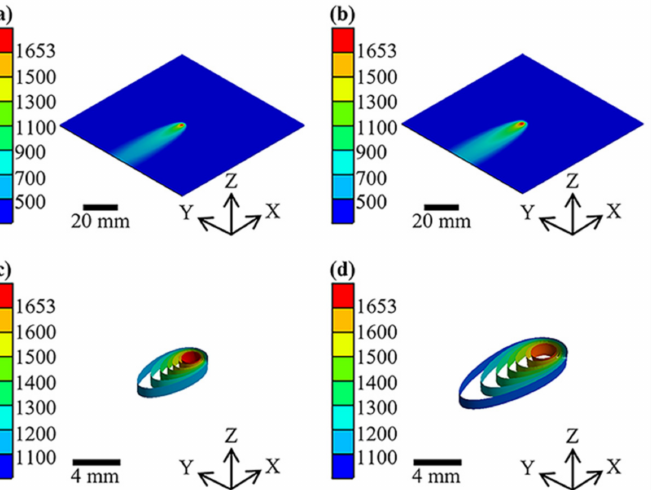
Figure 8. Temperature distribution at 2.5 s with currents of ( a ) 0 A and ( b ) 20 A. ( c , d ) Magnified views of the central region taken from the central areas in ( a , b ),